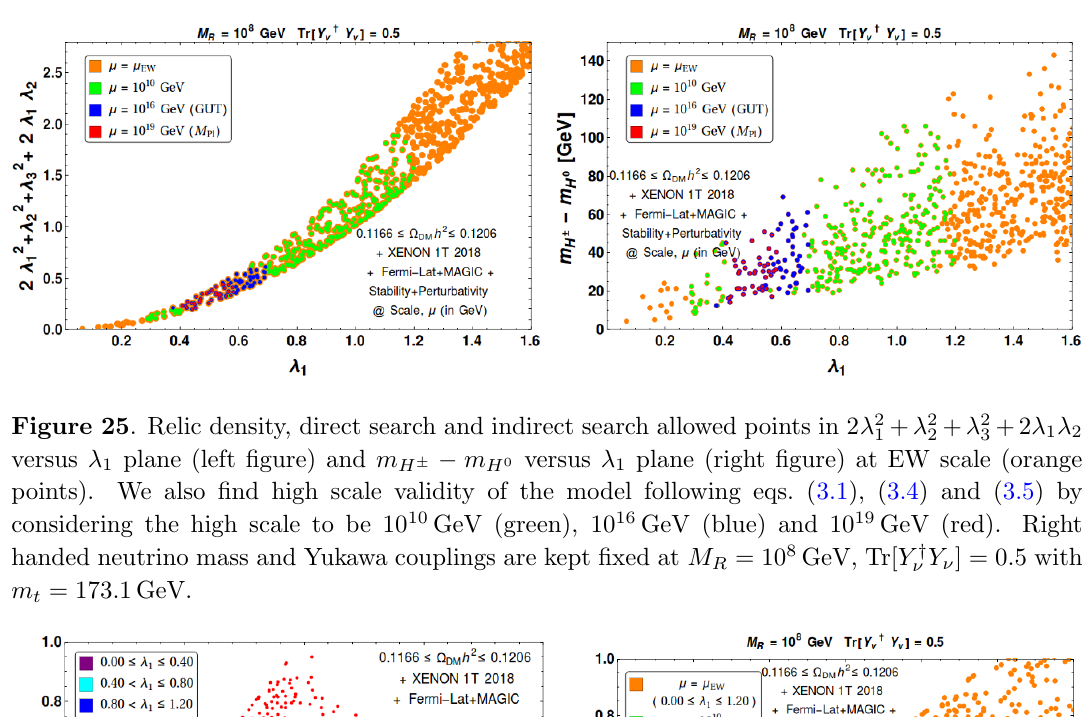
(cid:0) m versus (cid:21) 1 plane (right (cid:12)gure) at EW scale (orange H 0 H (cid:6)